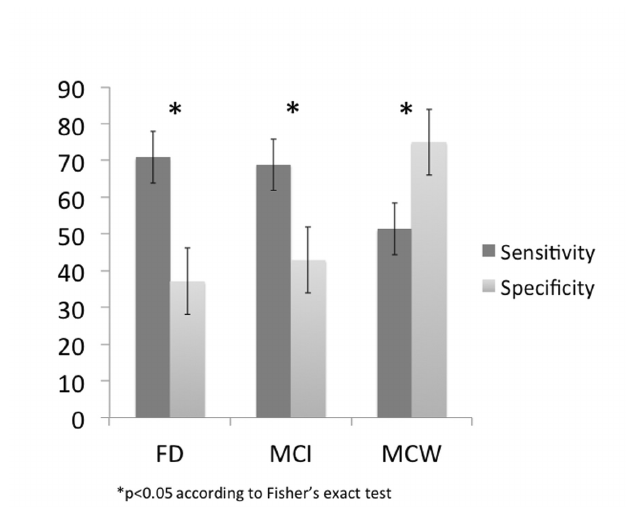
Fig.2. Diagnostic performance of the analyzed methods for screening low BMD. Abbreviations: FD, Fractal Dimension; MCI, mandibular cortical index; MCW, mandibular cortical